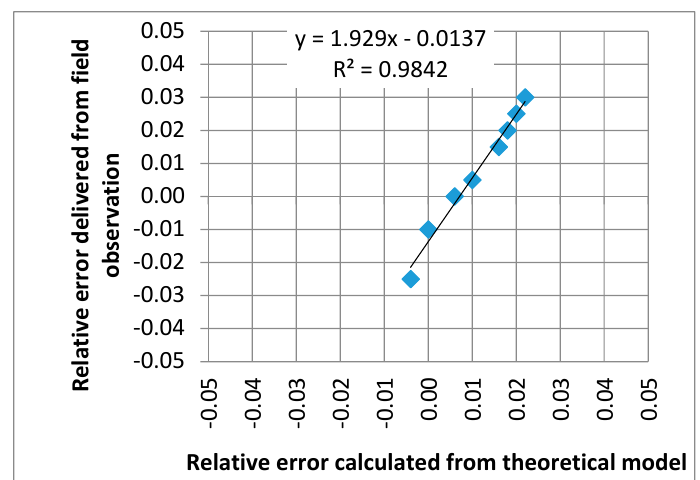
Figure 11. Comparison of relative errors for the quartz sensors delivered from field observations and from the theoretical model for the range of temperatures from 5 °C to 40 °C.